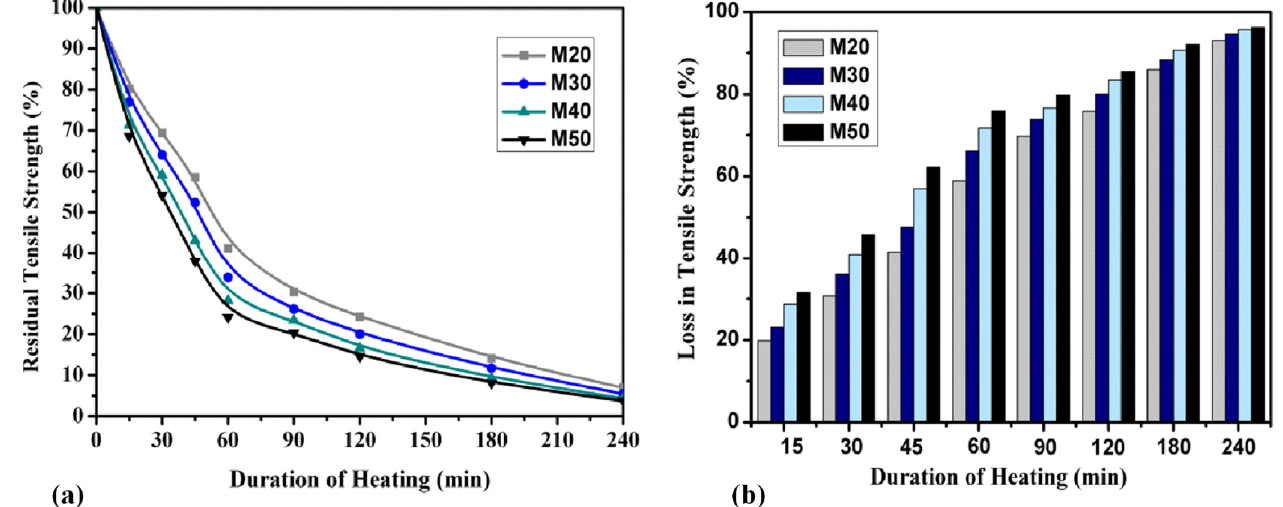
Figure 7. ( a ) Residual TS of concrete specimens, ( b ) loss of TS of concrete specimens.